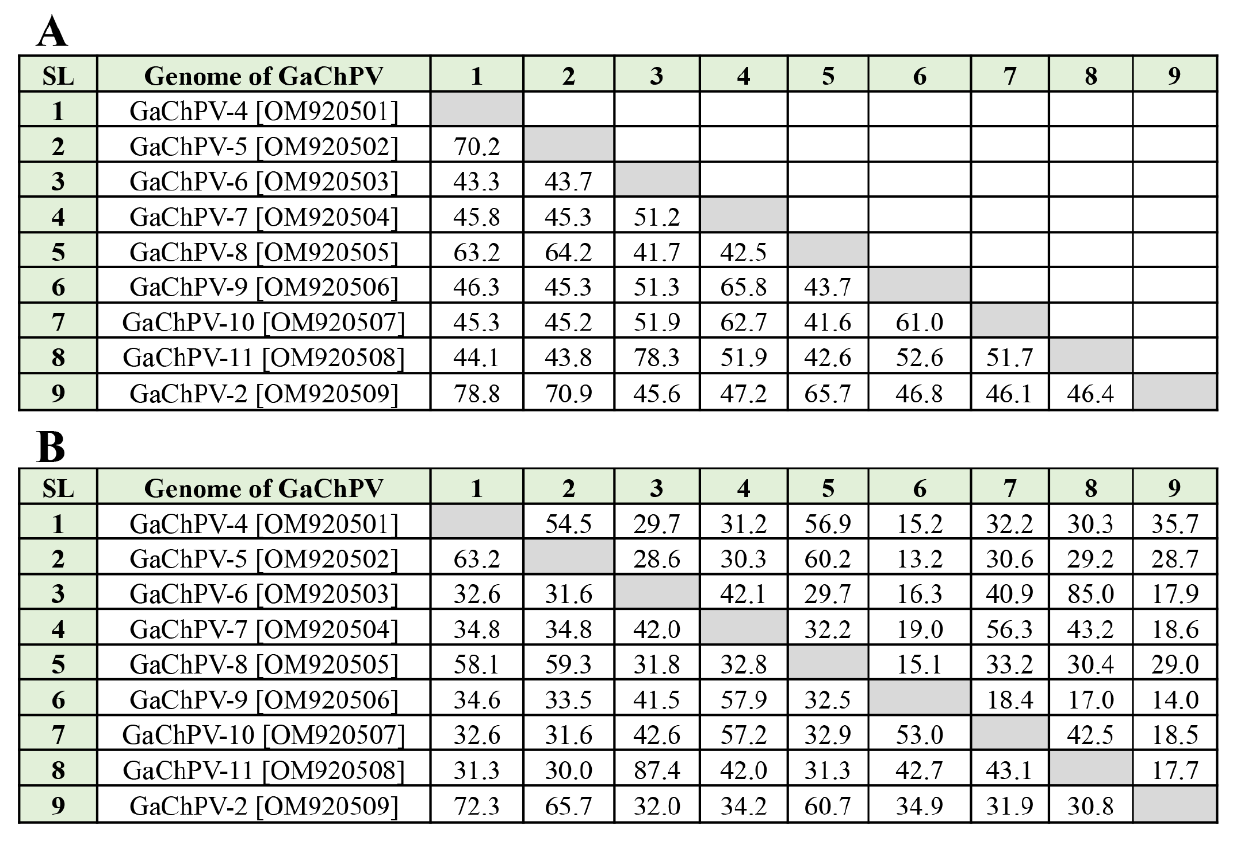
Figure 2. Comparison of galliform chaphamaparvovirus (GaChPV) genome sequences in this study. ( A ) Pairwise similarities percentage among GaChPV genome sequences in this study. ( B ) Pairwise comparison among GaChPV complete coding sequences of major genes. Upper comparison panel indicates the similarities percentage between two sequences of capsid gene (VP1), and lower comparison panel indicates the similarities percentage between two sequences of nonstructural protein 1 (NS1). SL denotes serial number.